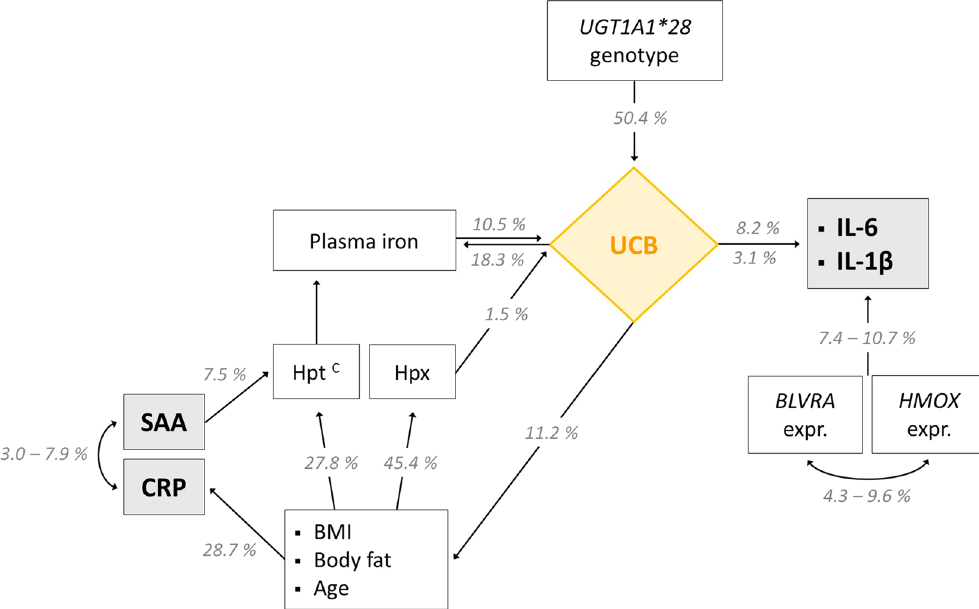
Figure 4. Intracellular levels of interleukins are related to circulating UCB and underlying molecular measures of heme catabolism. Figure 4 shows explanatory powers of parameters that are involved in the heme catabolic pathway for variation in inflammatory markers. Inflammation appears to be directly influenced by UCB on the one hand, and by HMOX/BLVRA genetic expressions on the other. As far as UCB was concerned, a further connection with markers of inflammation was found that was mainly established through the variables of body composition (BMI, BF). Variation in the unspecific inflammatory marker of CRP is merely explained by the demographic variable age as well as body composition. The interconnection of iron and UCB emphasizes a potential feedback-loop of UCB on heme catabolism. Stepwise linear regression analysis was performed to assess inter-variable dependence and explanatory power (%), based on corrected R 2 values and a p-value of ≤ 0.05 (Supplementary Table S4). C Effect valid for control subjects only. Abbreviations: UCB: unconjugated bilirubin; UGT1A1 : UGT1A1 genotype; IL-6/IL-1 β : intracellular interleukins 6 and 1 β ; BLVRA expr.: genetic expression of biliverdin reductase; HMOX expr.: genetic expression of heme oxygenase; Hpt: haptoglobin; CRP: C-reactive protein; SAA: serum amyloid